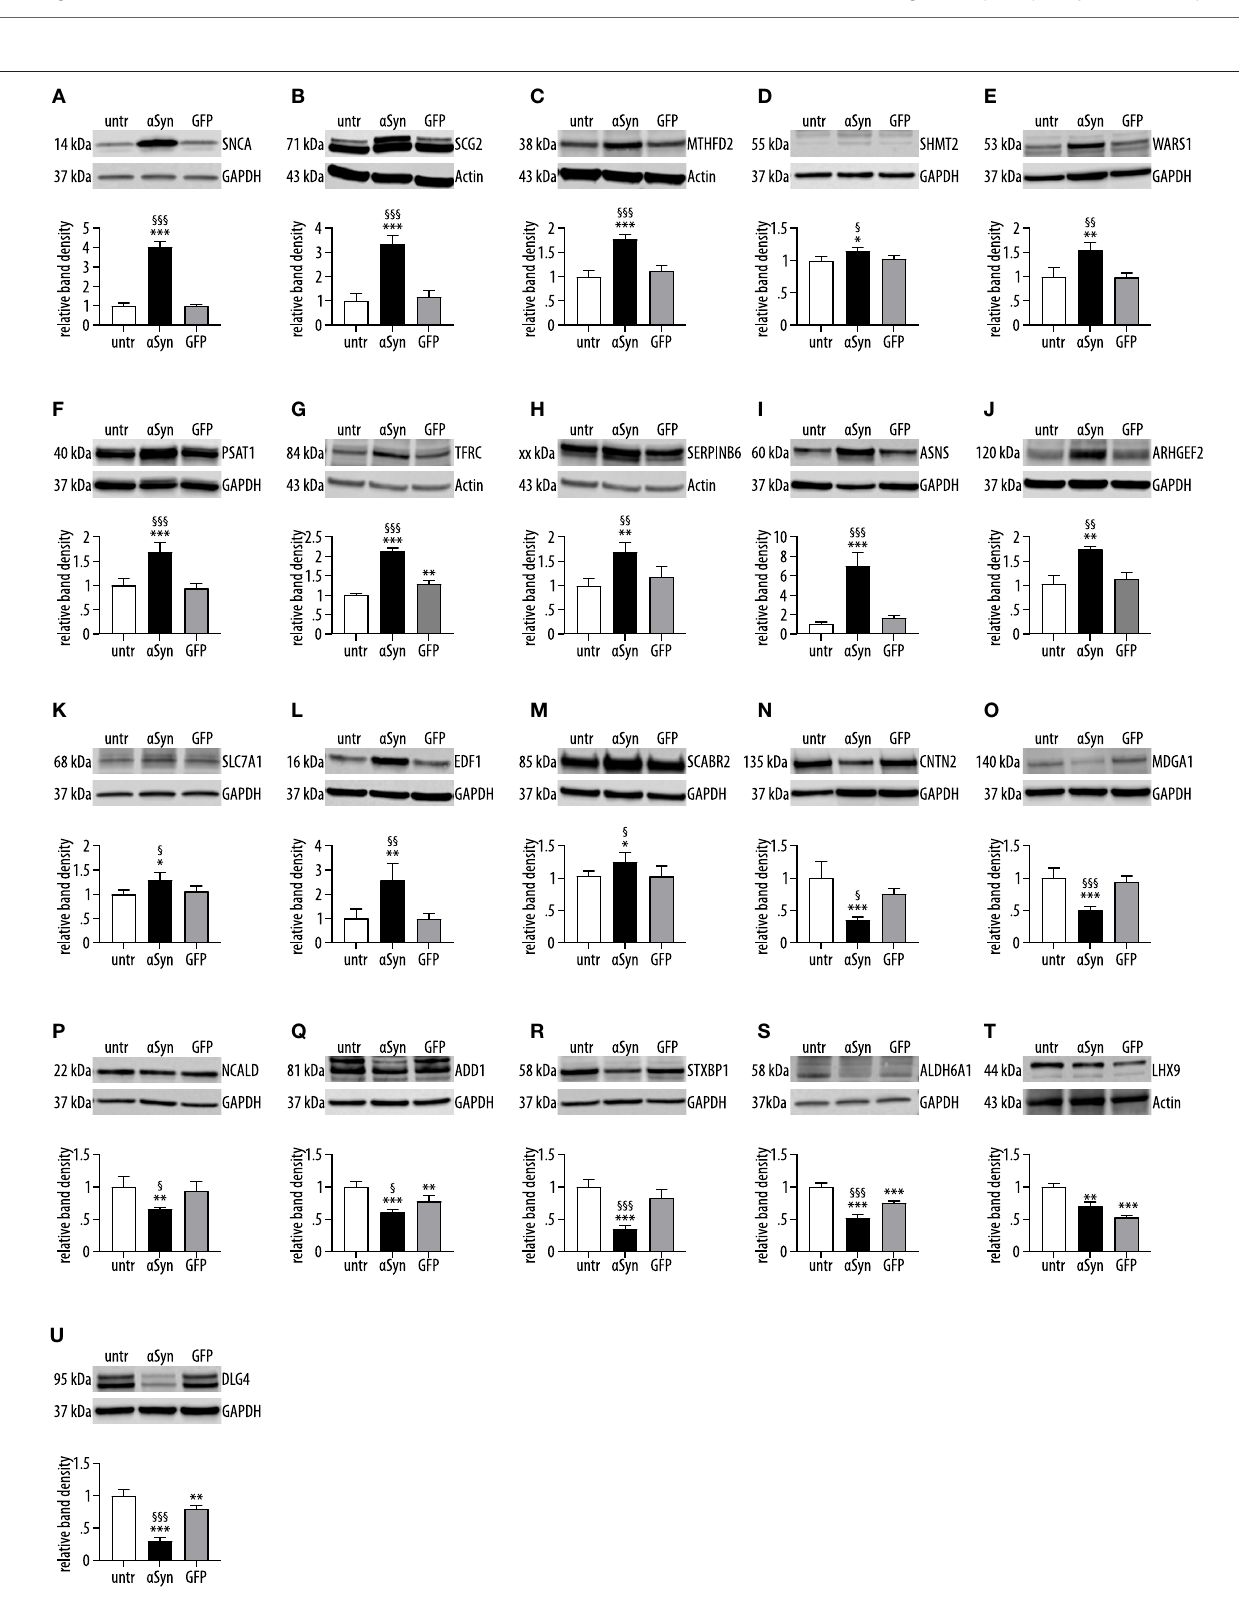
FIGURE 3 | Western blots confirmation. Western blots with antibodies against the 21 proteins that were differentially regulated in the proteomics, of which the corresponding genes were also differentially regulated. For the Western blot investigation, samples from untransduced cells (untr), α Syn-overexpressing cells ( α Syn), and GFP-expressing cells (GFP) cells were used. The proteins are presented in the same order as in Table 3 . (A) SNCA, synuclein alpha; (B) SCG2, Secretogranin II;